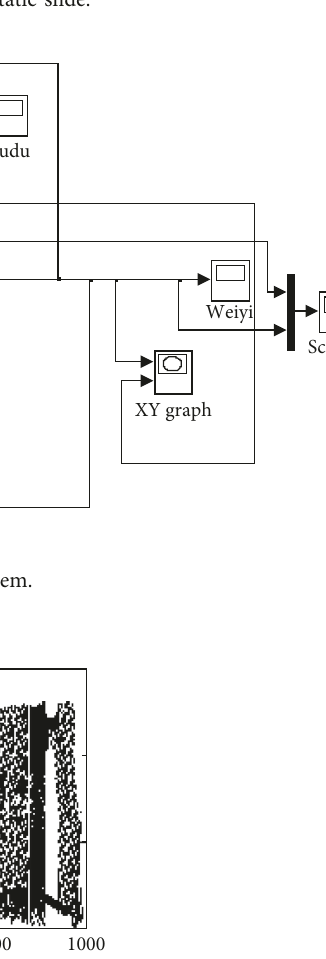
Figure 4: Chaos critical curve of the hydrostatic slide.